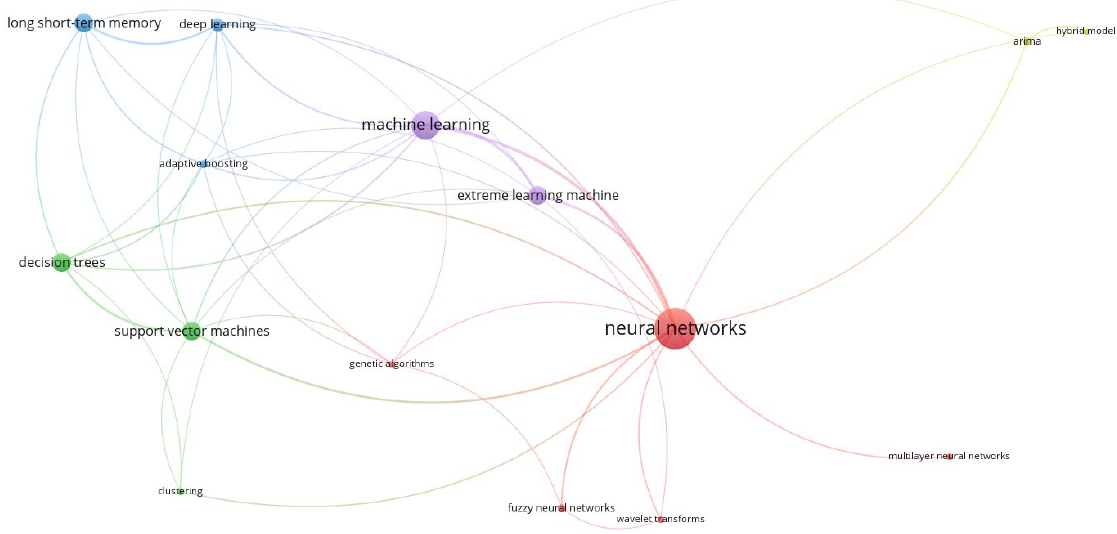
Figure 4. Bibliometric map of keywords co-occurrences (minimum 5) results from Scopus based on modified Query 1. Source: Authors’ elaboration performed in the VOSviewer (version 1.6.18).